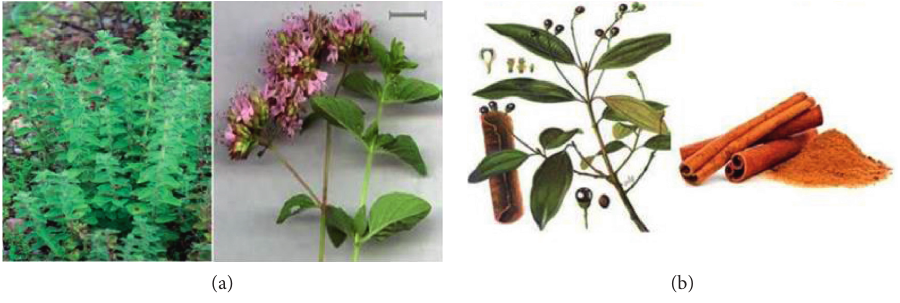
Figure 1: (a) O. compactum and (b) C. cassia [16,